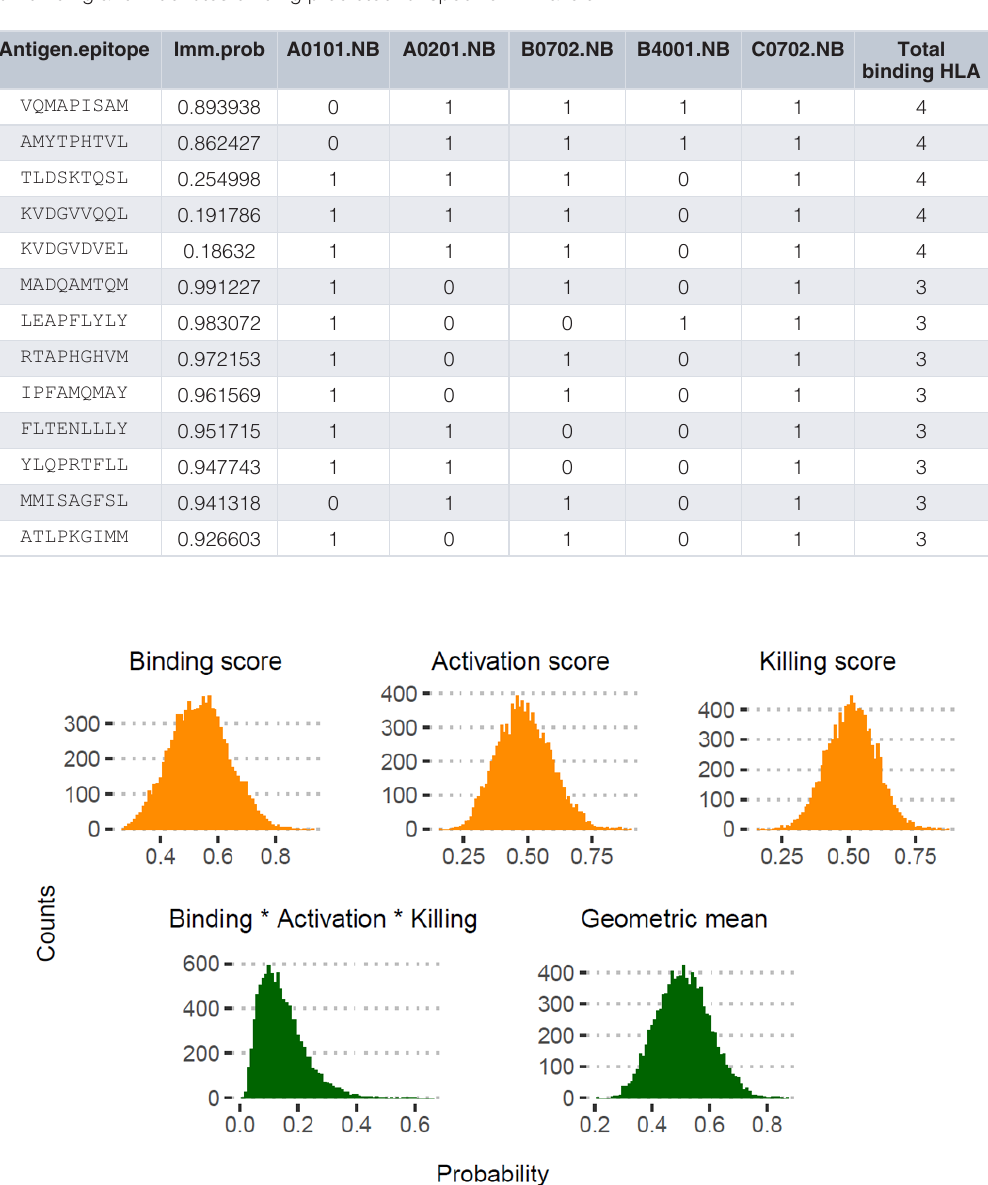
Table 3. 2019-nCoV 9-mer peptides predicted to bind 4 different HLA alleles by NetMHCpan 4.0, and those predicted to bind ≥ 3 HLA alleles and immunogenicity score ≥ 0.9 by iPred. For different alleles, 0 denotes non-binding and 1 denotes binding predicted for specific HLA allele.